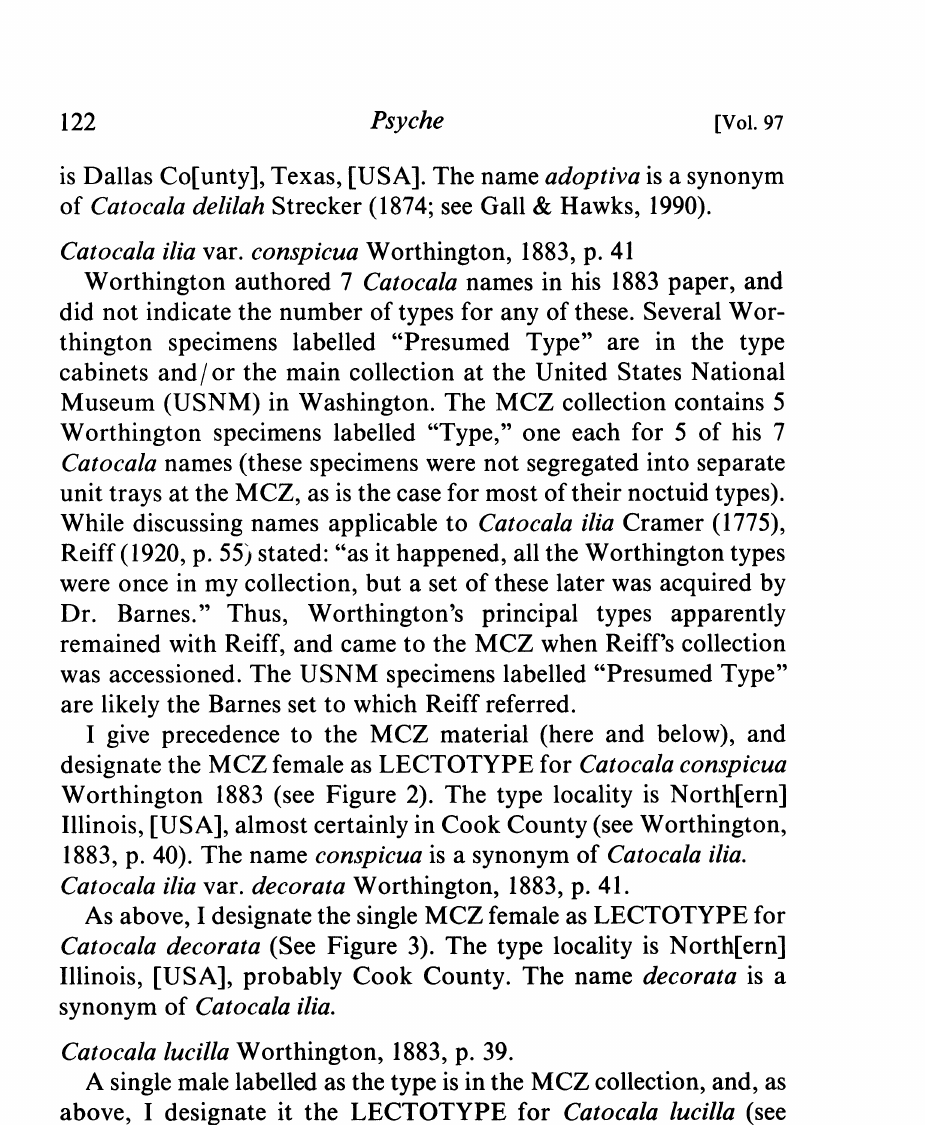
Table 1. [facing page] Synopsis of taxonomic actions taken herein